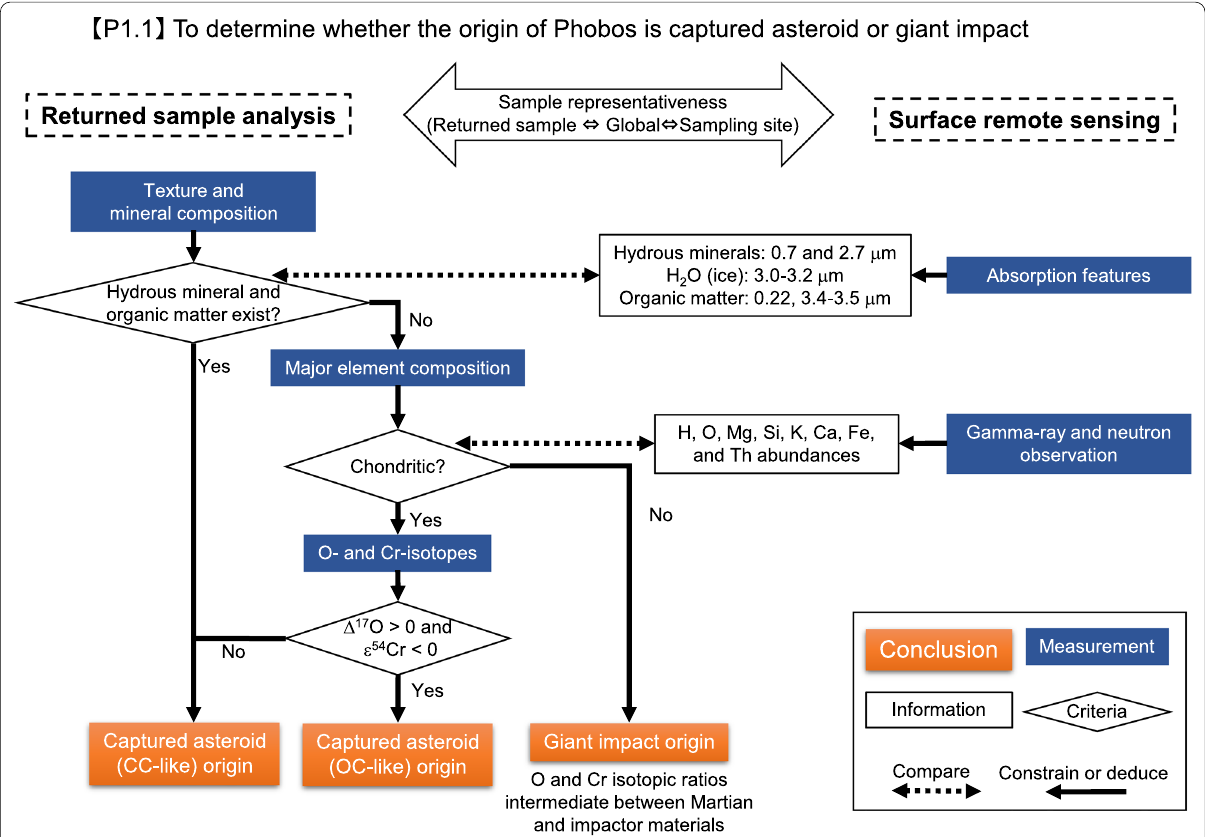
Fig. 1 Flowchart of sample analyses together with remote sensing observations to determine the origin of Phobos (objective 1.1 in Table